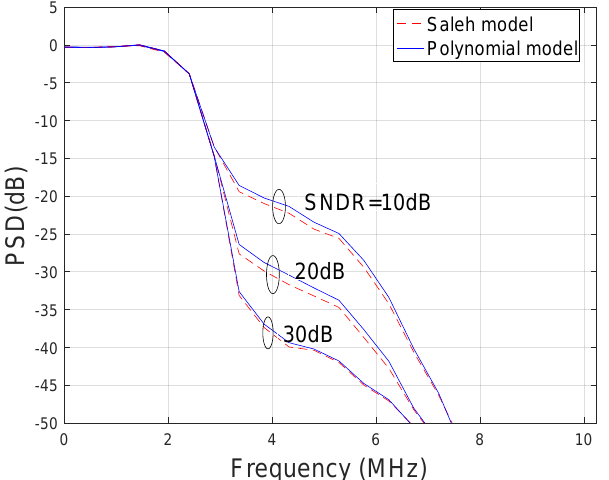
Figure 9. Power spectral density (PSD) of the information signal after nonlinear PA. In the simulation, we select the OFDM signal with the bandwidth of 5 MHz as the information signal and the multitone sine signal as the energy signal, and we create the power spectral density images of the information signal after PA of Class B when the given SNDR of I(1) is 10 dB, 20 dB, 30